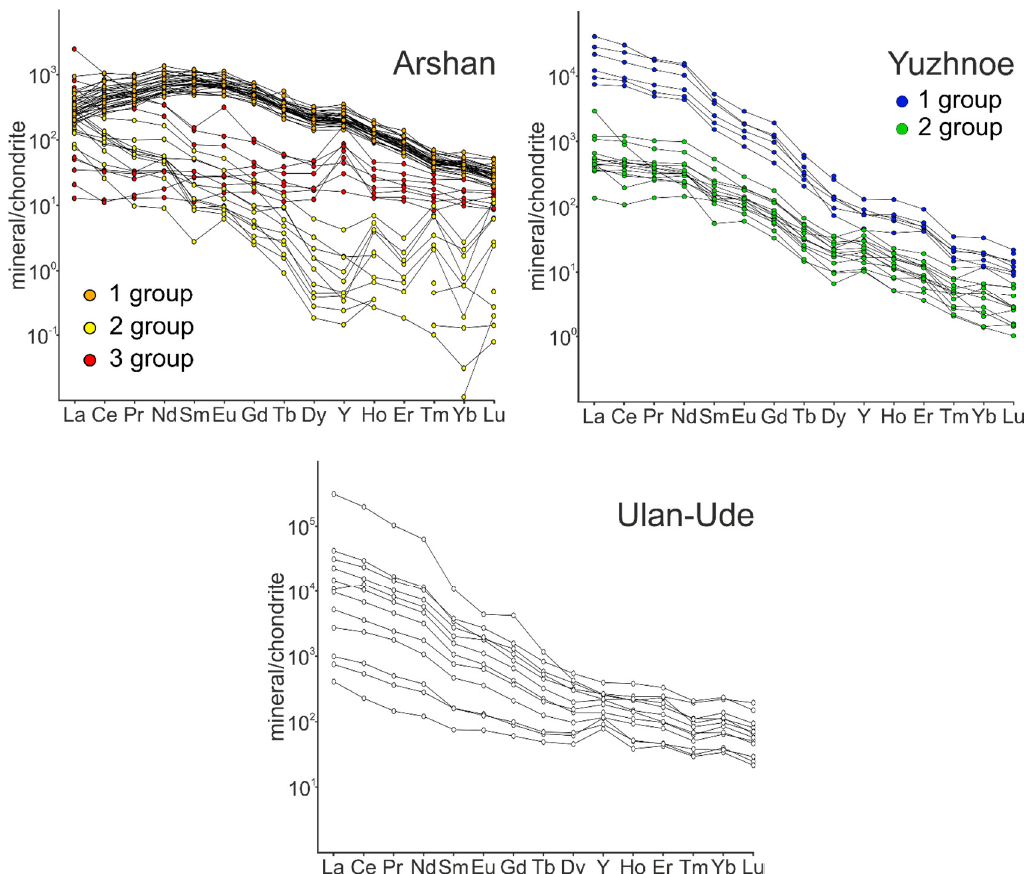
Figure 2. Chondrite-normalized REE + Y spectra of the fluorites [26]. Fluorite of the second and the third groups host multiphase crystal-fluid or CF-type (Figure 3a,b) and double-phase vapor-liquid (VL-type) inclusions (Figure 3f,g). Data on Table 1. Trace element compositions (ppm) of fluorites from Arshan, Yuzhnoe and Ulan-Ude occurrences. fluid inclusions are accumulated in Table 2. The study of primary CF and secondary VL Occurrence Arshan Yuzhnoe inclusions allowed us to trace the evolution from initial orthomagmatic to hydrothermal mineralized fluid. Primary CF inclusions occur in small clusters in the central parts of the grains. They are isometric or elongated and up to 20 µ m in size. Daughter mineral phases occupy 50–90 vol.% of the inclusions, and are represented by Na-Ca-Sr sulfates (sharp peaks at 995–1010 cm − 1 , 1132 cm − 1 , 1155–1160 cm − 1 and triple peak at (610–)621–635–650 cm − 1 ) and Na-Sr carbonates (peak at 700–707 cm − 1 and double peak at 1075–1078 cm − 1 ). Ther- mometric tests of the primary CF inclusions indicate homogenization temperatures (T h ) of 420–560 ◦ C and salinities of 50–67 wt.% NaCl-equiv. Gaseous phase (~8 vol.%) consists of CO 2 ± N 2 ± H 2 . Secondary VL inclusions trace cracks thought several quartz grains and have irregular shapes and sizes of 2–8 µ m. Gaseous phase occupies about 30–50 vol.% and is close to pure CO 2 ( ± N 2 ). Ice melting temperatures for the secondary VL inclusions vary between − 8 and − 10 ◦ C. Homogenization temperatures and salinity values range between 90 and 150 ◦ C, and 11.7–13.9 wt.% NaCl-equiv. respectively. These results indicate that Arshan fluorites were formed from a homogeneous high-temperature sulfate-carbonate fluid (main cations Na, Ca, Sr). This was subsequently diluted by meteoric waters with a decrease in temperature and